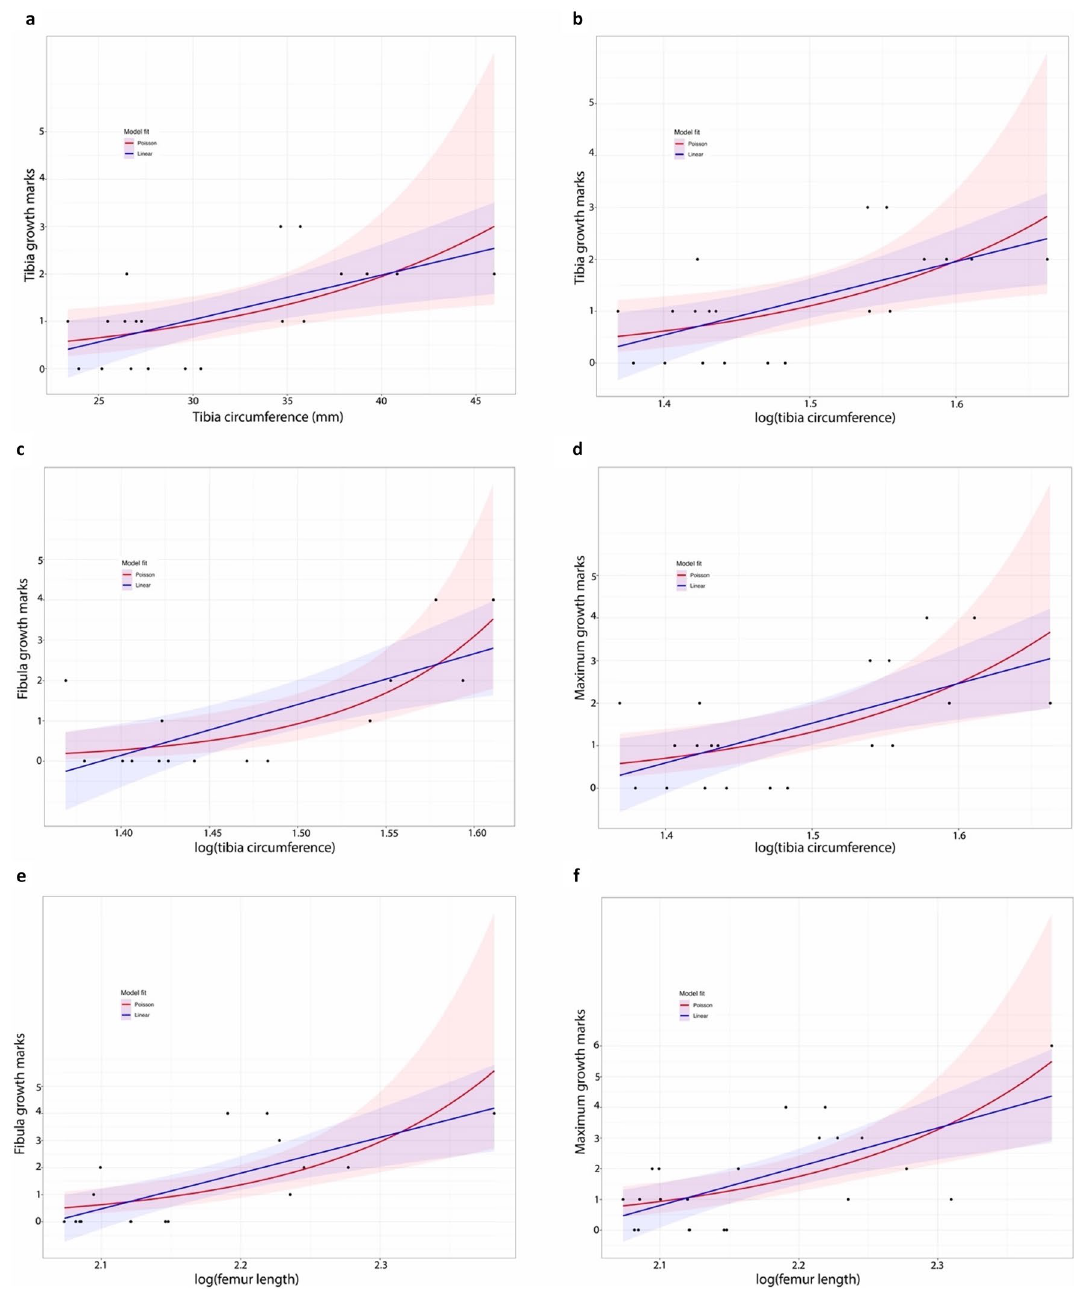
Figure 4. Body size proxies (tibia circumference or femur length) and the number of growth marks (an age proxy) have a significant, but highly variable, relationship in Coelophysis bauri . ( a ) Tibia circumference versus number of tibia growth marks. Linear: p = 0.0160, R 2 = 0.2688; Poisson: p = 0.0304, pseudo-R 2 = 0.1997. ( b ) Log(tibia circumference) versus number of tibia growth marks. Linear: p = 0.00388, R 2 = 0.3787; Poisson: p = 0.0160, pseudo-R 2 = 0.2821883. ( c ) Log(tibia circumference) versus number of fibula growth marks. Linear: p = 0.00261, R 2 = 0.5145; Poisson: p = 0.000895, pseudo-R 2 = 0.4777833. ( d ) Log(tibia circumference) versus maximum number of growth marks (either tibia or fibula). Linear: p = 0.00136, R 2 = 0.5061; Poisson: p = 0.00024, pseudo-R 2 = 0.3376748. ( e ) Log(femur length) versus number of fibula growth marks. Linear: p = 0.00097, R 2 = 0.5269; Poisson: p = 0.000172, pseudo-R 2 = 0.3812659. ( f ) Log(femur length) versus maximum number of growth marks (either tibia or fibula). Linear: p = 0.000802, R 2 = 0.4375; Poisson: p = 0.000247, pseudo-R 2 = 0.3467714. CMNH 10971 #1 has four to six growth marks in its fibula, so was plotted with four in ( e ) and six in ( f ). Blue shaded areas are the 95% confidence intervals for the linear regressions; those in red are the 95% confidence intervals for the Poisson